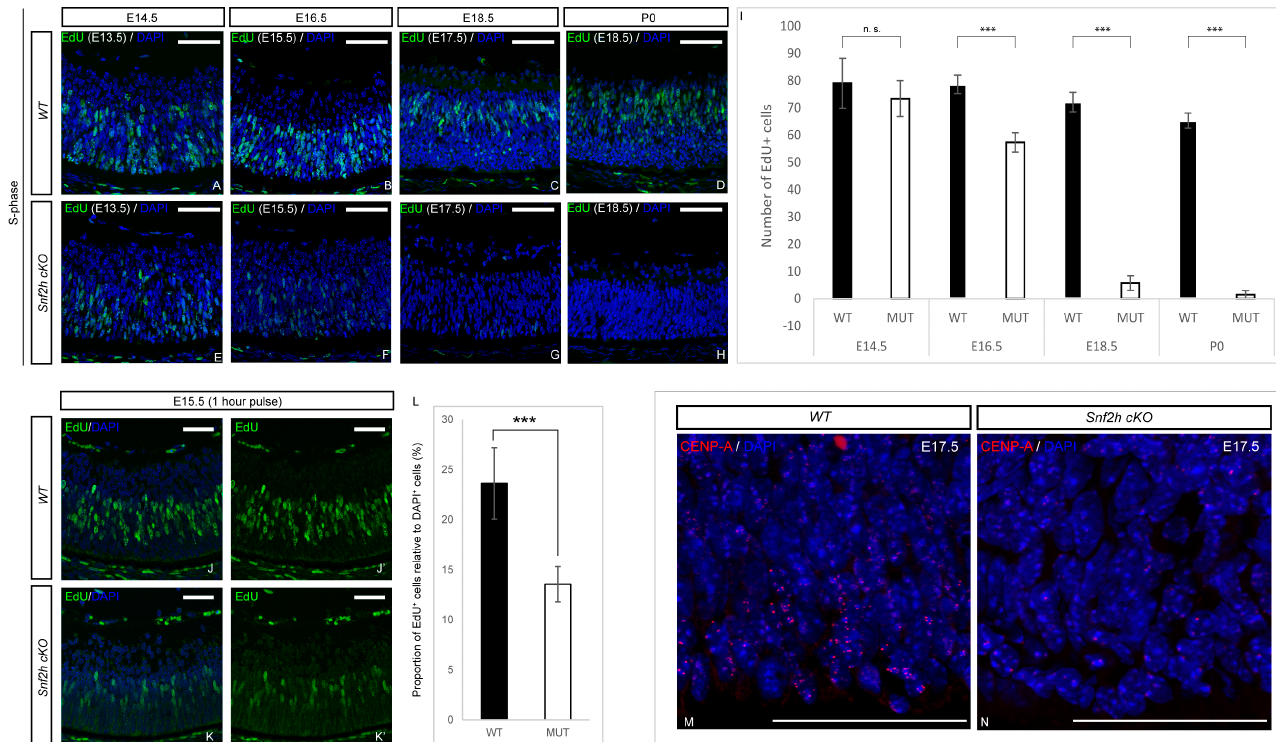
Figure 6. Cell-cycle analysis of Snf2h -deficient retinal cells. The retinal proliferation was analyzed via EdU incorporation. Pregnant females were intraperitonally injected with EdU 24 h prior to sacrifice at indicated stages. The number of EdU + cells in wild-type and Snf2h cKO mice was comparable until E14.5. The differences first appeared at E16.5—the number of EdU + cells was decreased by ~25% in Snf2h -deficient mice compared with controls. Subsequently, at E18.5 and after birth, almost no EdU + cells were detectable in Snf2h cKO, in contrast with the massive proliferation rate in wild-type retinae ( A – I ). Pregnant females were injected with EdU one hour prior to sacrifice. The proportion of EdU + cells/DAPI + cells was reduced in Snf2h -deficient retina at E15.5 ( J , J ’, K , K ’, L ). Expression of CENP-A (centromere protein A) at E17.5. CENP-A is essential for centromere localization and proper chromosomal segregation. The CENP-A antibody staining was widespread in wild-type retinae at E17.5 ( M ), whereas in Snf2h -depleted retinae, only a few CENP-A-positive cells were found ( N ), indicating impaired chromosomal segregation in Snf2h cKO retinal cells. Error bars indicate standard derivation; p -values were calculated using Student’s t -test ( n = 4). *** p < 0.001, n.s. = not significant. Scale bars: 50 µ